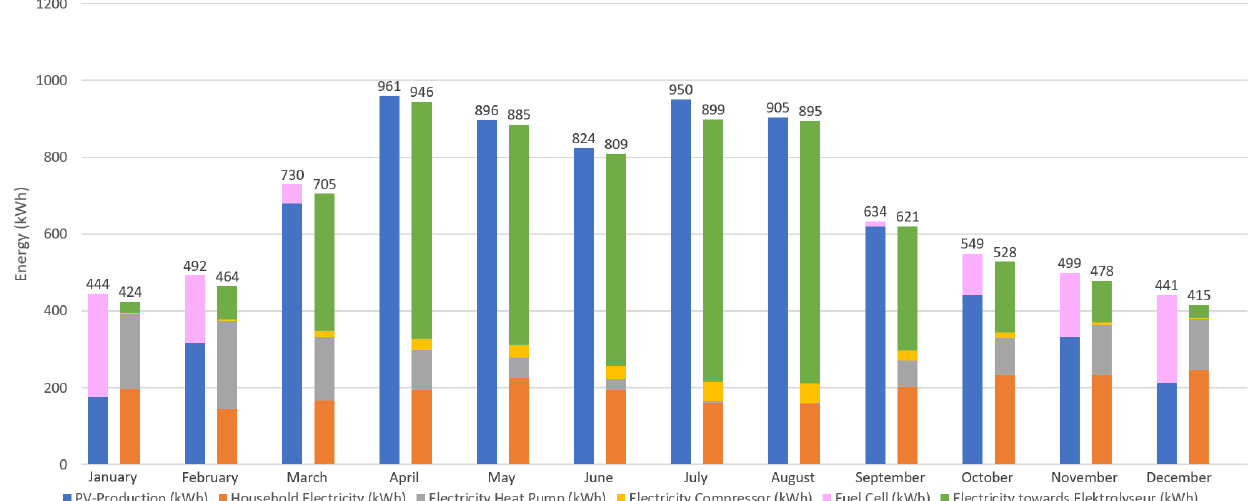
Figure 14. Energy production ( left bar ) and energy consumption ( right bar ) calculated by Simulink simulation for each month.